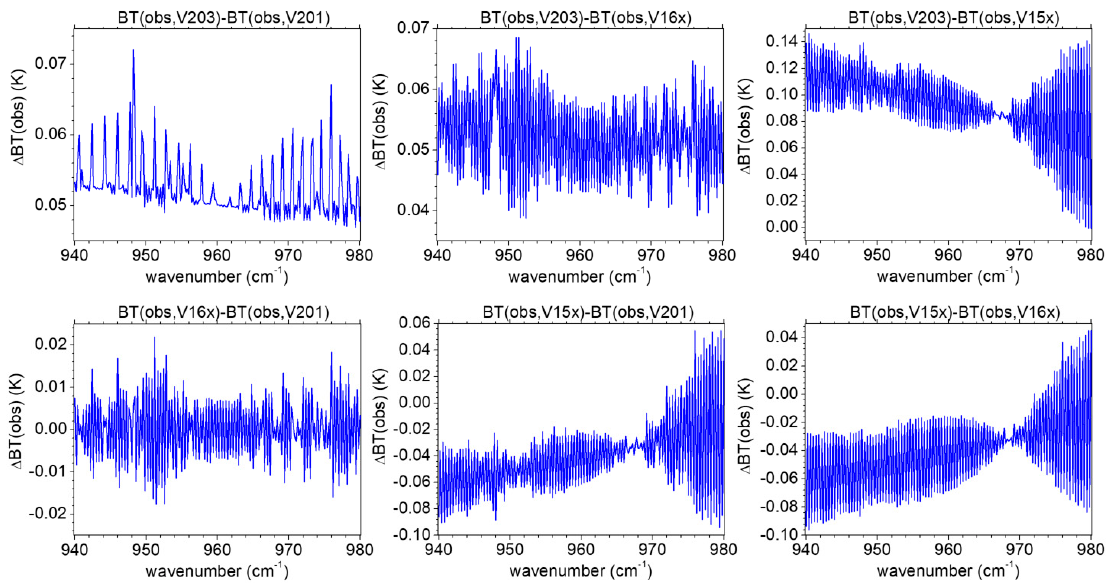
Figure 4. Brightness temperature difference between versions. First row, from left to right: V203-V201, V203-V16x, V203-V15x. Second row: V16x-V201, V15x-V201, V15x-V16x. Note the quite expanded vertical scales in BT.